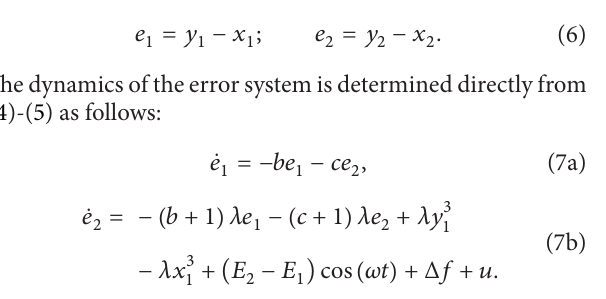
Table 2: Variation of coronary artery system response with vibra- tional amplitude over interval 0.1 ≦ 𝐸 ≦ 20.0 . 𝐸 Dynamic